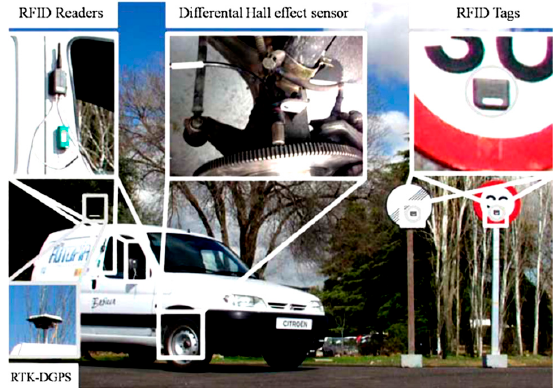
Figure 21. A depiction of the various sensors deployed on a car for experimenting [57].